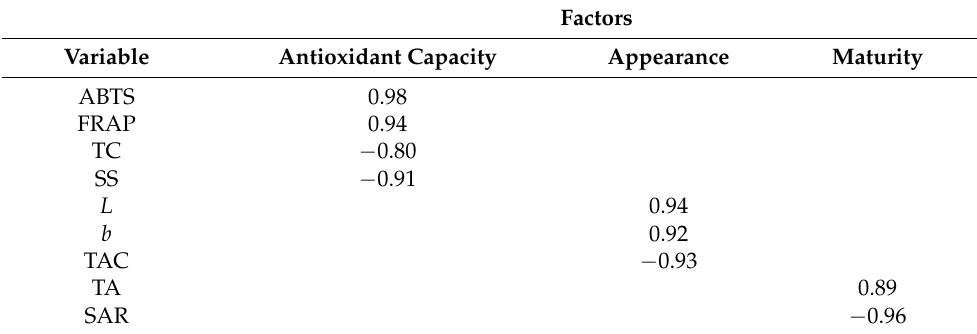
Table 3. Factors identified based on the variables evaluated in the tree tomato breeding population.